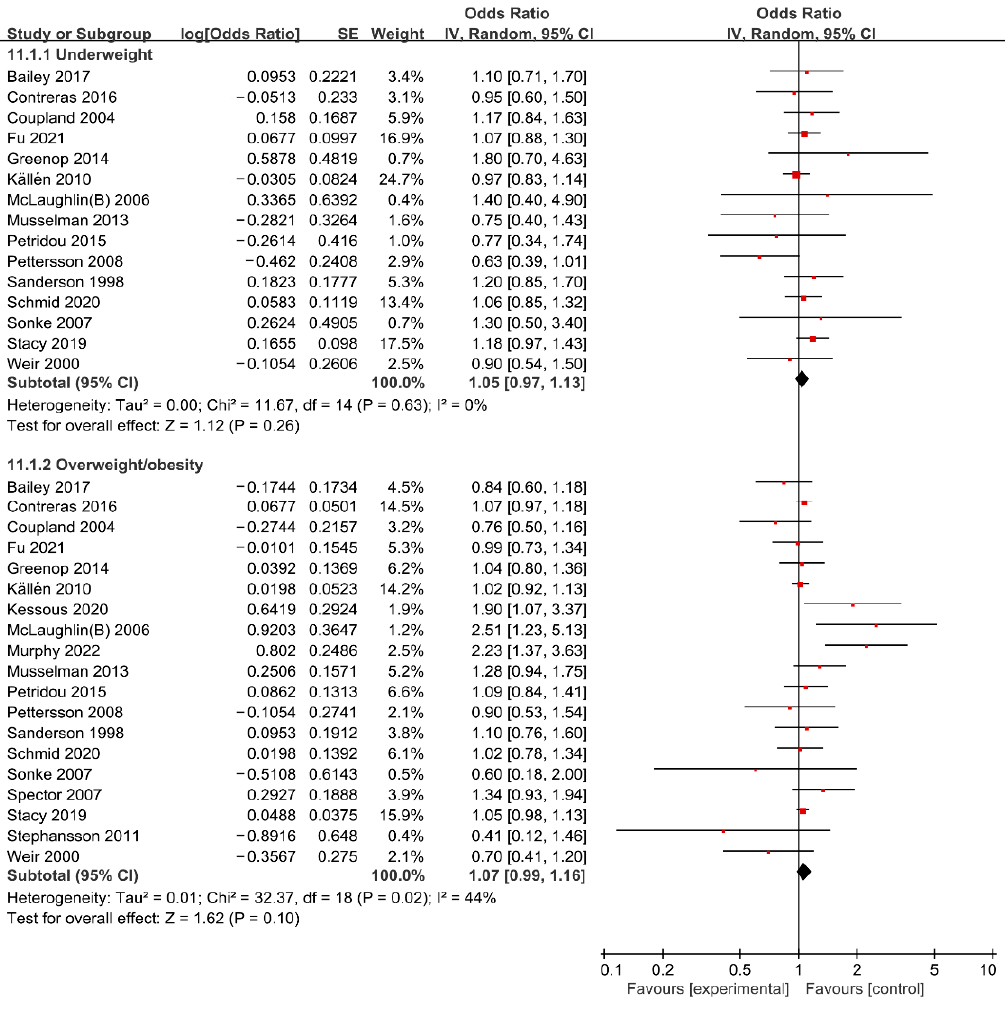
Figure 2. Forest plot of the association between maternal BMI and the risk of total cancer in